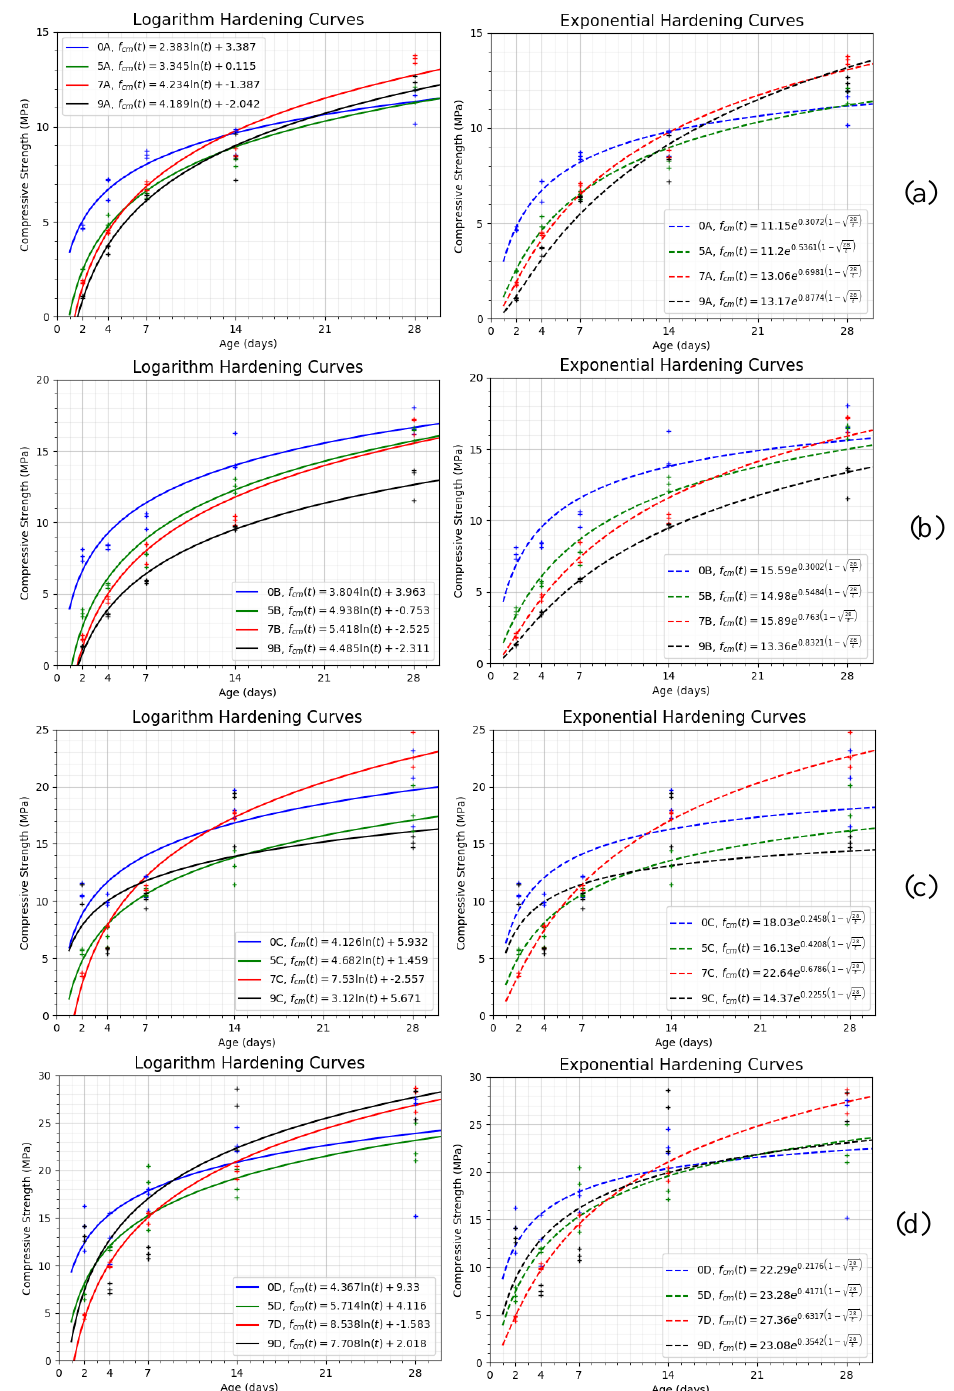
Figure 8. Compressive Strength. Logarithm and exponential hardening curves to 28 days. 0% to 90% substitution. ( a ) A mixtures. ( b ) B mixtures. ( c ) C mixtures. ( d ) D mixtures.